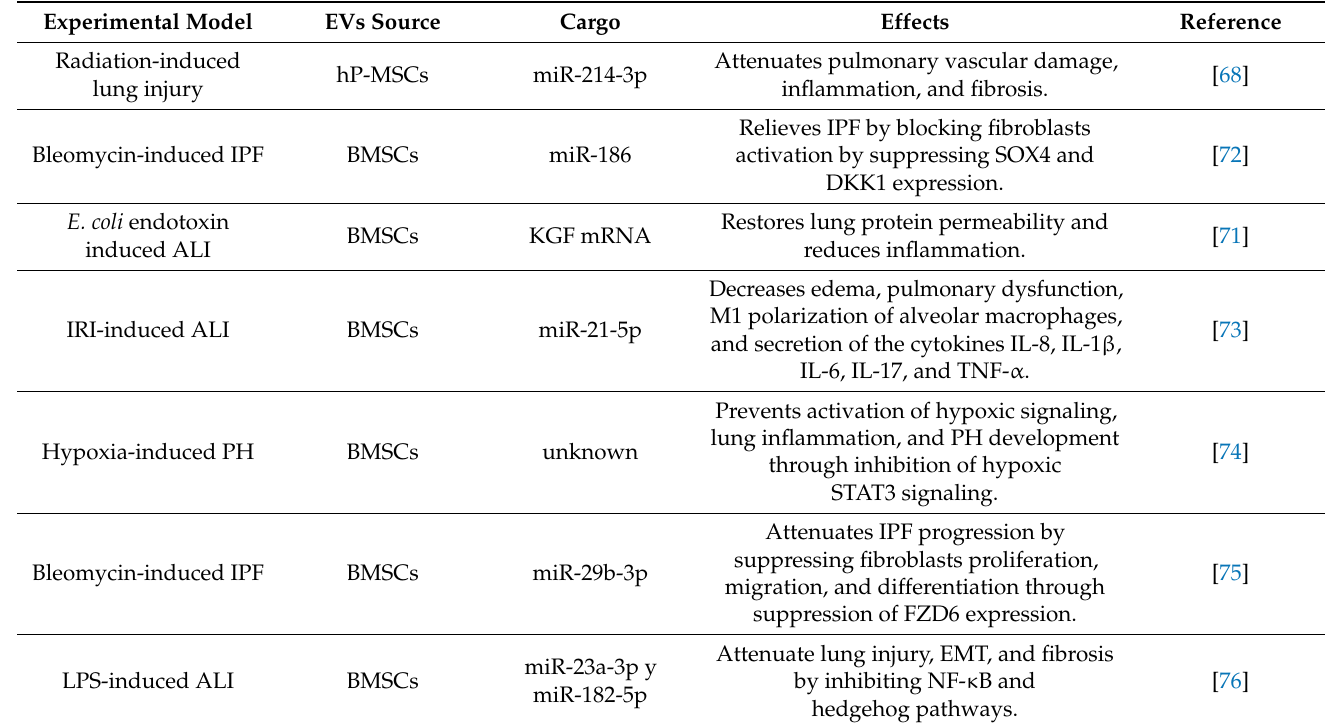
Figure 3. Function of stem cell-derived EVs. MSCs from either menstrual blood, bone marrow, placenta, or adult organs, such as the lung, exert a therapeutic effect through their secretome, which contains EVs that transport miRNAs that regulate several processes, including inflammation, by decreasing neutrophil recruitment, reducing cell proliferation, decreasing the apoptosis of injured epithelium and proinflammatory cytokines secretion, and reducing fibroblasts activation by transferring miRNAs. Table 1. Summary of studies in animal models of IPF with therapeutic MSC-EVs.